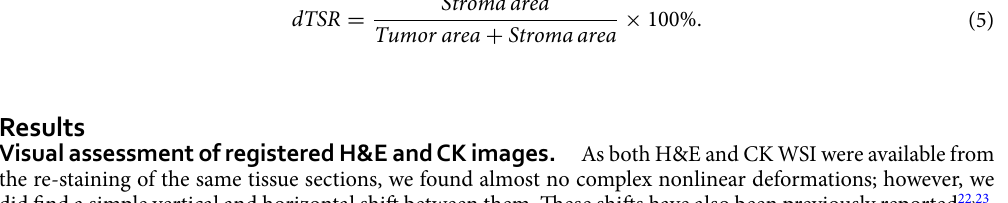
Figure 4. Pairs of hematoxylin and eosin (H&E) and cytokeratin (CK) staining patch images after